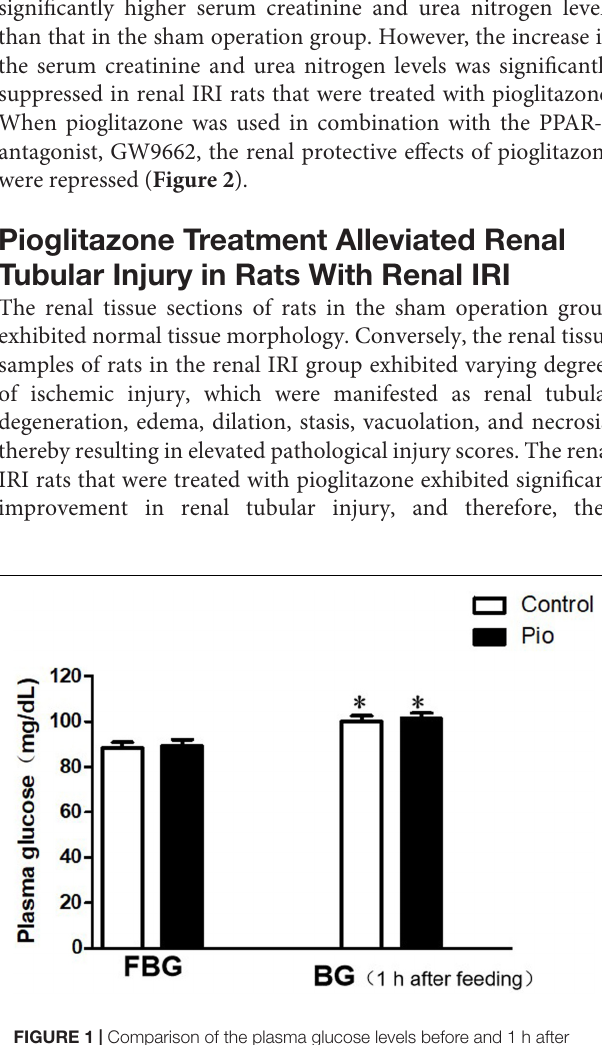
FIGURE 1 | Comparison of the plasma glucose levels before and 1 h after feeding. There were no significant differences in the plasma glucose levels before and 1 h after feeding between the control and pioglitazone-treatment group. Values are expressed as mean ± SE ( n = 6). (FBG, fasting blood glucose; BG, blood glucose). Compared to FBG, ∗ represents p <